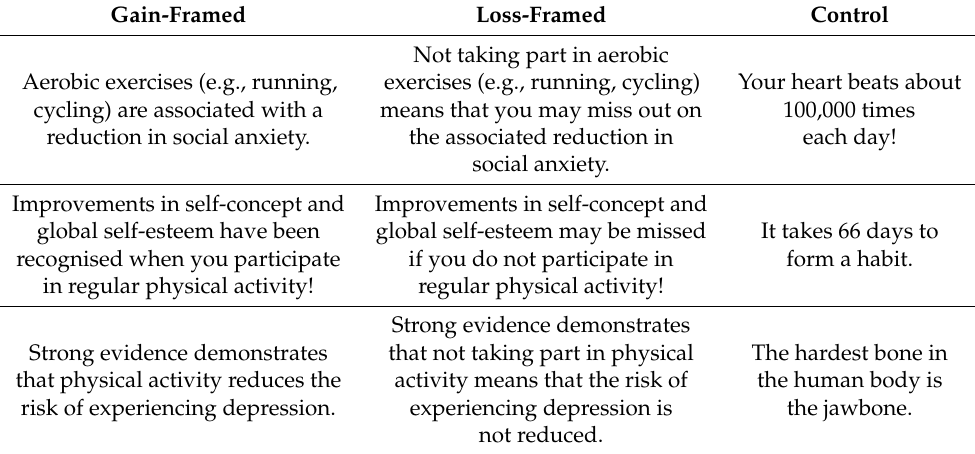
Table 1. Examples of gain-framed, loss-framed and control messages delivered throughout the intervention on separate Facebook